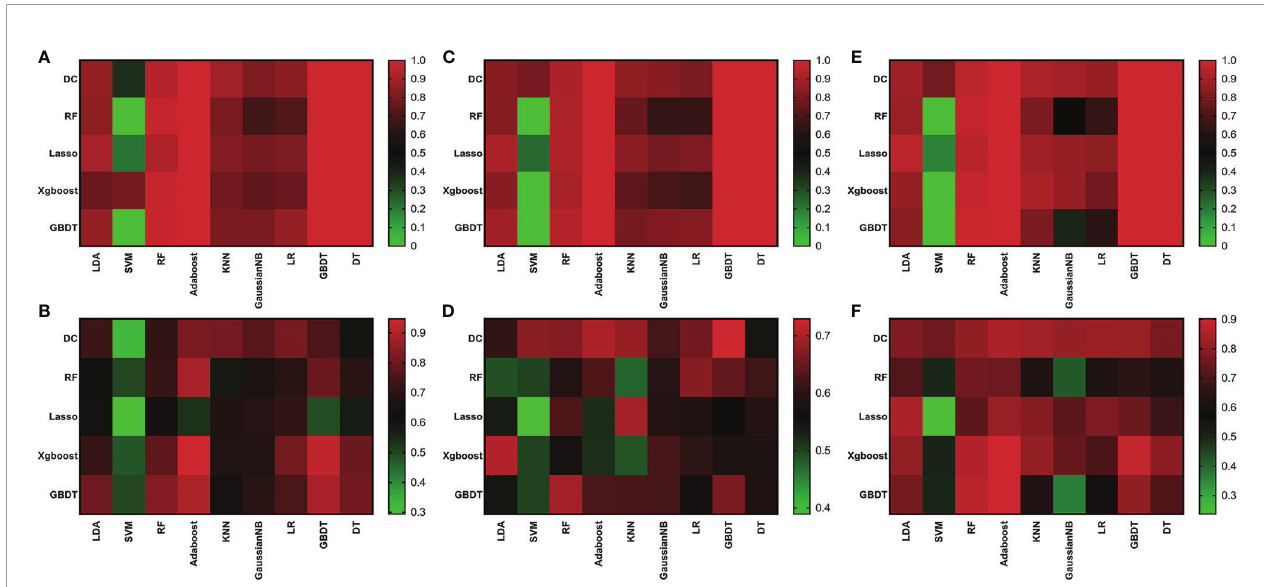
FIGURE 3 | Heat map of AUC results of all algorithms. Training set of G1 vs G2 (A) ; Validation set of G1 vs G2 (B) ; Training set of G2 vs G3 (C) ; Validation set of G2 vs G3 (D) ; Training set of G1 vs G3 (E) ; Validation set of G1 vs G3 (F)